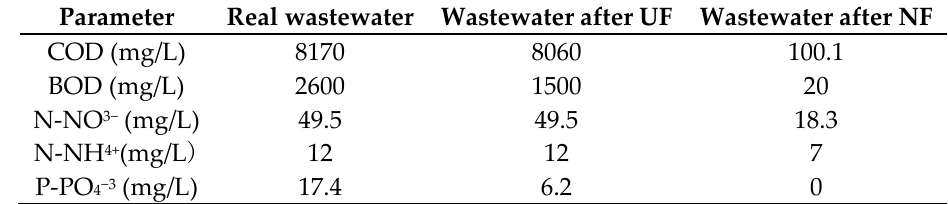
Table 3. Value of pollution indicators for raw, after ultrafiltration and after nanofiltration